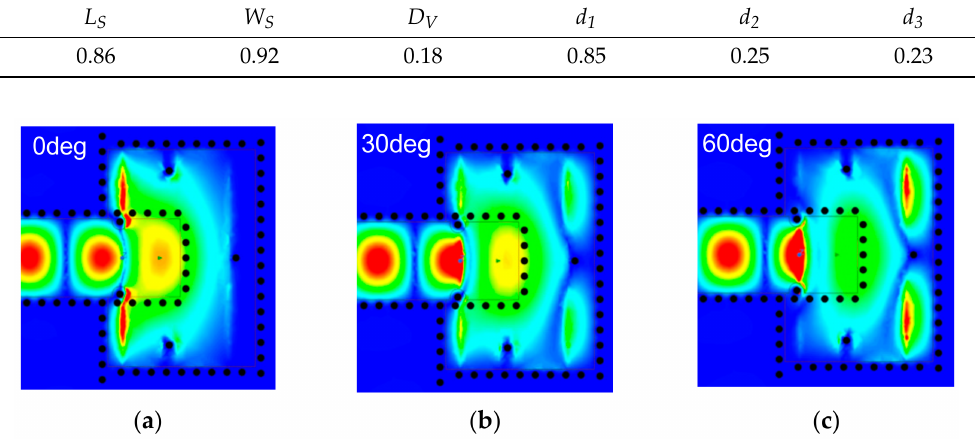
Figure 5. E -field distribution in the proposed transition with different phases: ( a ) Phase = 0 ◦ ; ( b ) Phase = 30 ◦ ; and ( c ) Phase = 60 ◦